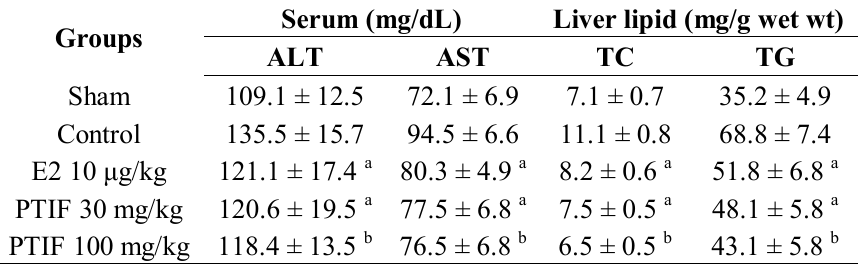
Table 2. Effects of PTIF on OVX-induced hepatic steatosis. Data are the mean ± SEM values ( n = 12 per group). a A significant decrease at p < 0.05, when compared with the control group; b A significant decrease at p < 0.01, when compared with the control group; ALT, alanine transaminase; AST, aspartate aminotransferase; TC, total cholesterol; TG,